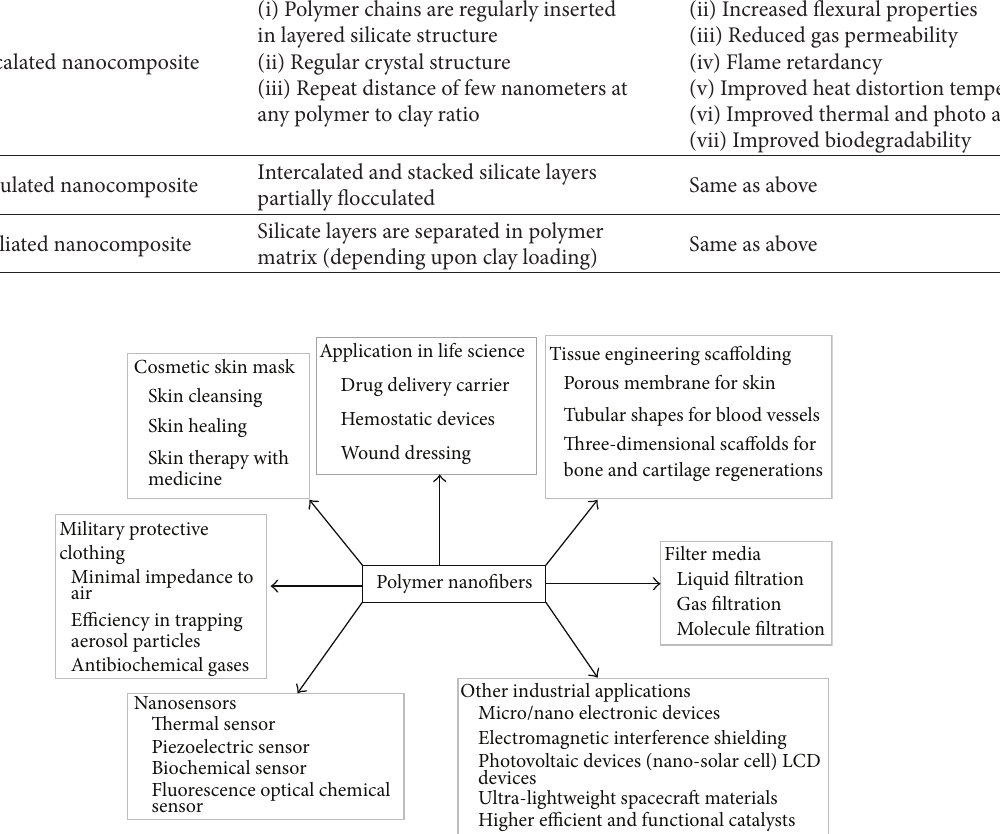
Figure 2: The possible applications of polymer nanofibers produced using clay mineral-polymer (nm) composite [17].